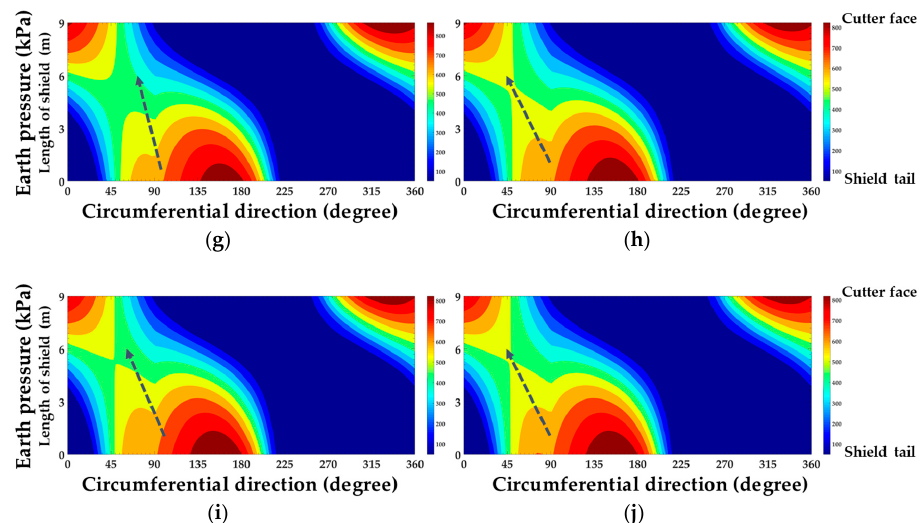
Figure 18. Shield stress nephogram at each moment: ( a ) 1 min; ( b ) 2 min; ( c ) 3 min; ( d ) 4 min; ( e ) 5 min; ( f ) 6 min; ( g ) 7 min; ( h ) 8 min; ( i ) 9 min; and ( j ) 10 min.